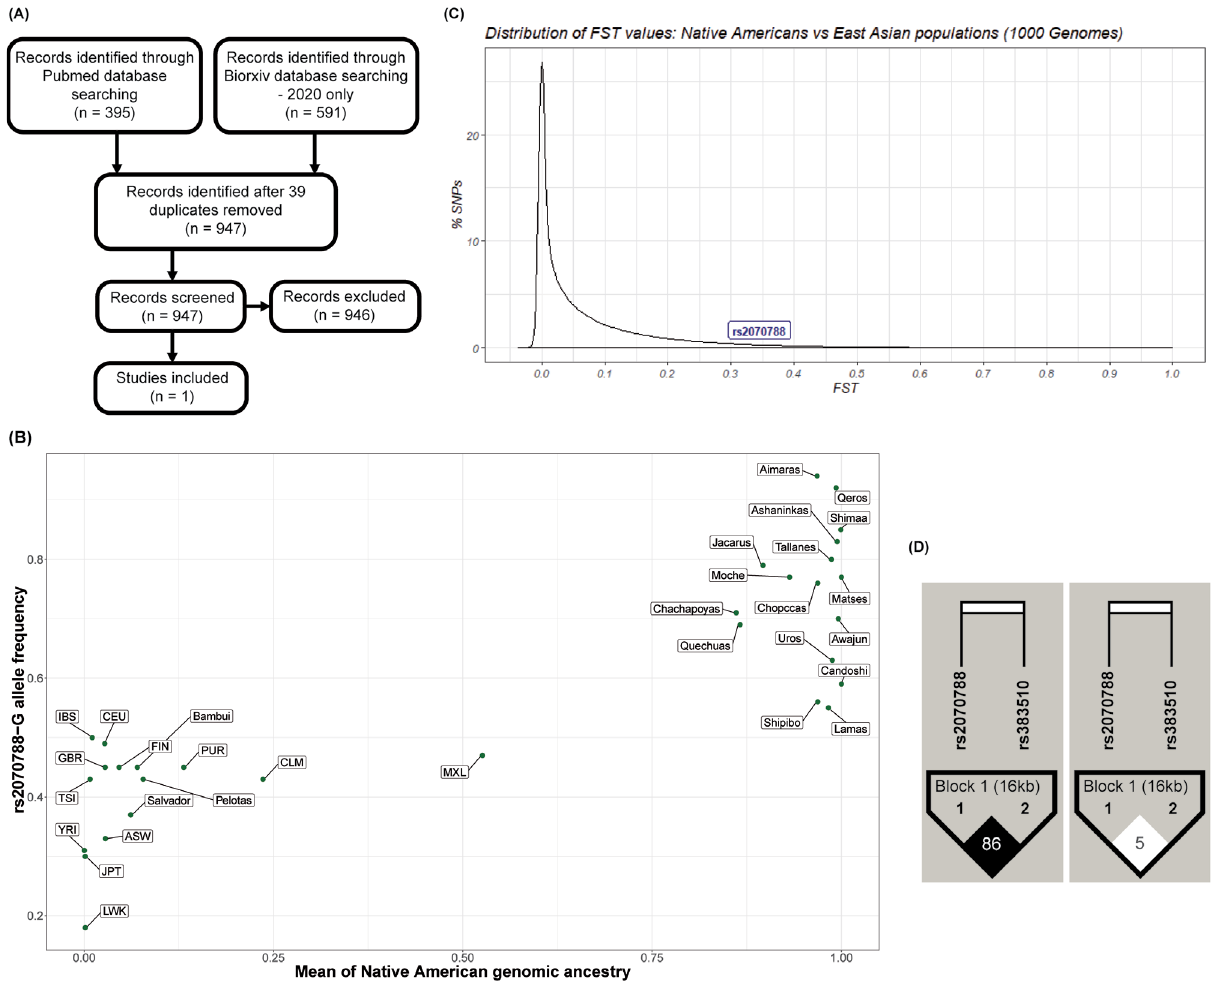
Figure 1 ‒ (A) PRISMA flowchart of the systematic review; (B) Frequencies of the rs2070788 SNP and Native American ancestry in different populations (Populations form 1000 Genomes Project: ASW, Americans of African Ancestry in SW USA; CEU, Utah Residents (CEPH) with Northern and Western European Ancestry; CLM, Colombians from Medellin, Colombia; FIN, Finnish in Finland; GBR, British in England and Scotland; IBS, Iberian Population in Spain; JPT, Japanese in Tokyo, Japan; LWK, Luhya in Webuye, Kenya; PUR, Puerto Ricans from Puerto Rico; TSI, Toscani in Italia; YRI, Yoruba in Ibadan, Nigeria); (C) Fst values distribution of Native Americans vs East Asian populations for 71 SNPs of TMPRSS2 gene; (D) Linkage disequilibrium between rs2070788 and rs383510 in East Asian and Native American